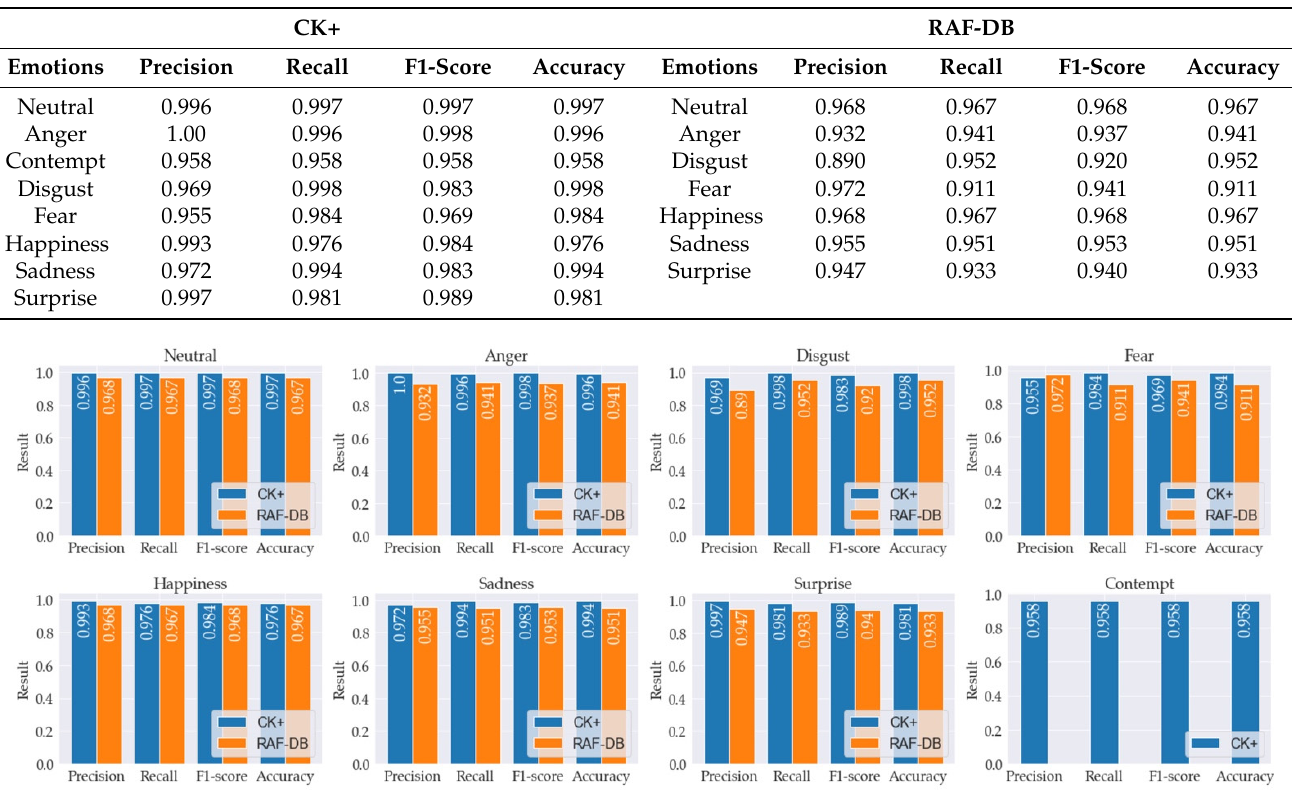
Table 3. Accuracy metrics of the proposed method on the CK+ and RAF-DB data sets.